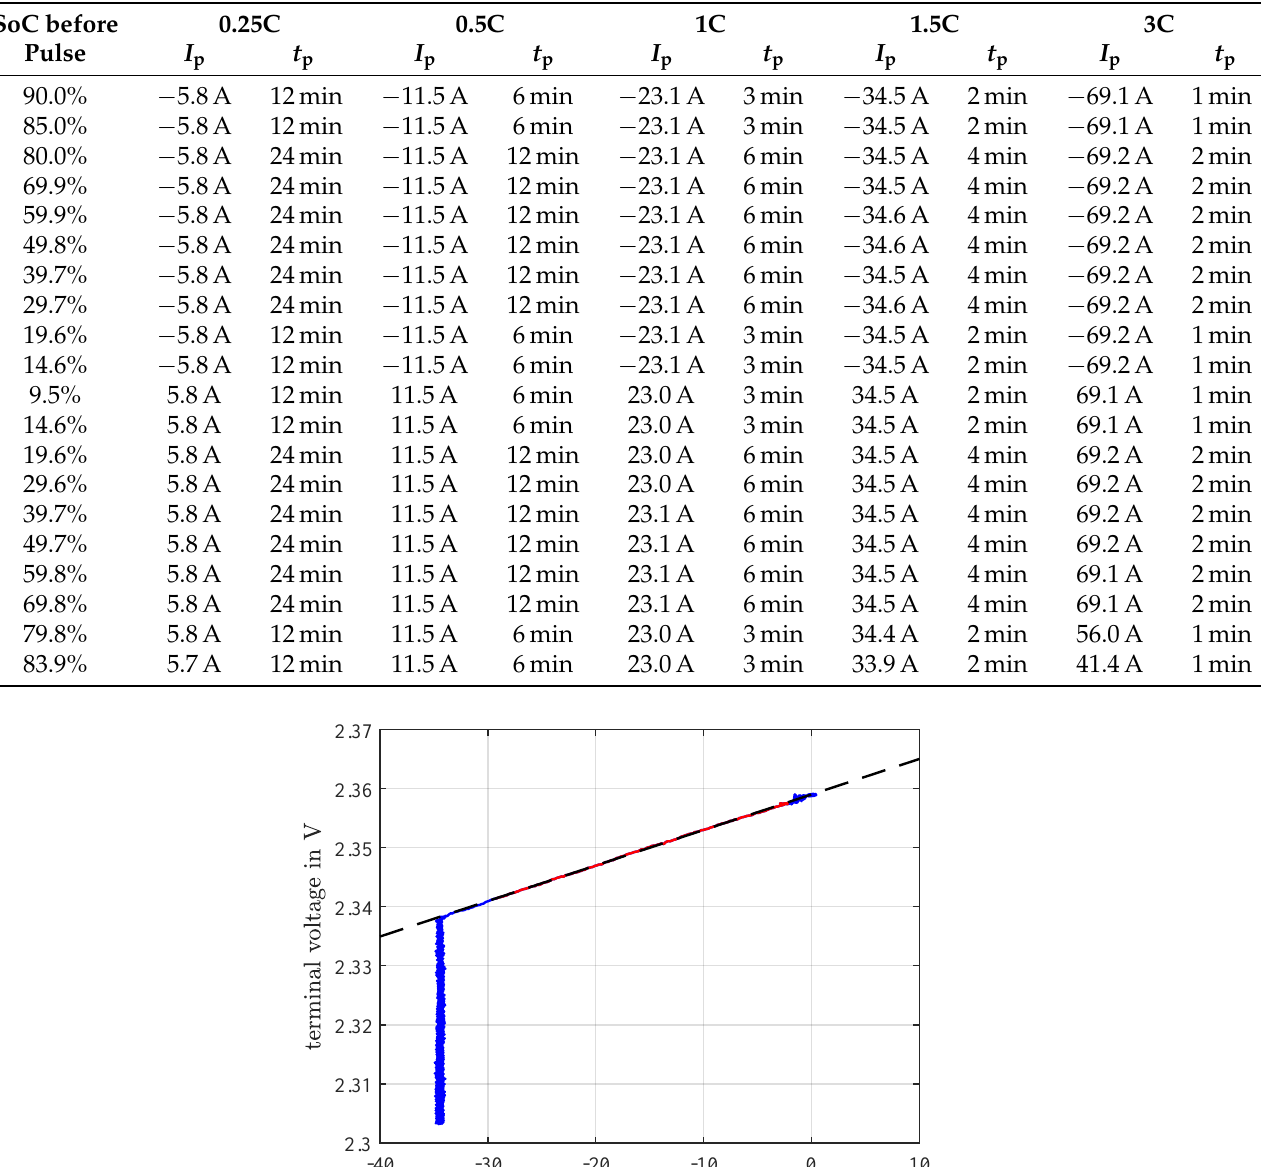
Table 1. Sequence of applied current pulse amplitude and duration for the five conducted experiments. The transferred electrical charge q el and therefore the SoC levels are identical in all experiments.